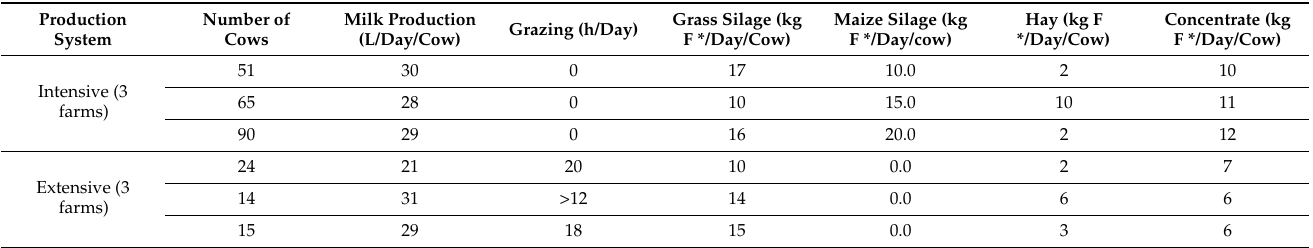
Table 1. Characteristics and diet of cows on the dairy farms where milk was sampled for RNA sequencing.